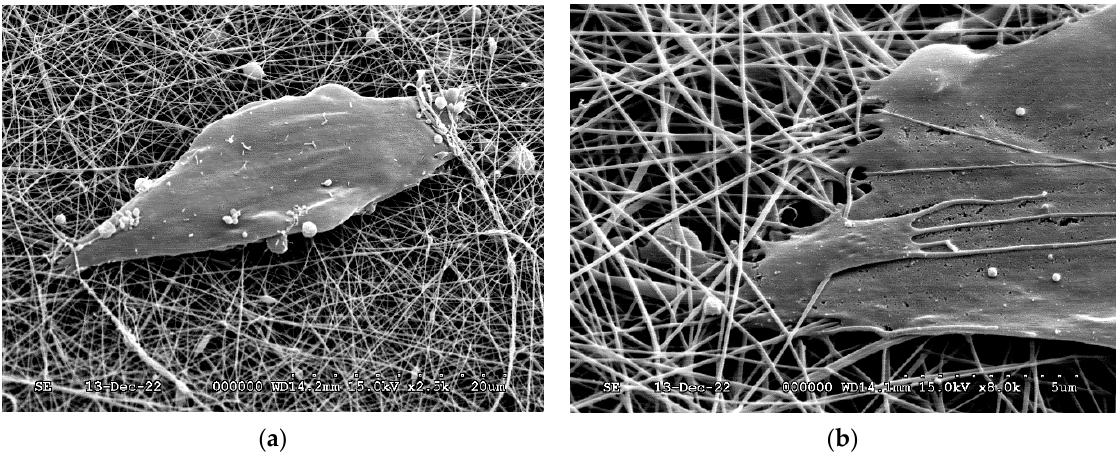
Figure 10. SEM micrographs of DPSCs on the surface of the BTCP-AE-FM ( a , b ).